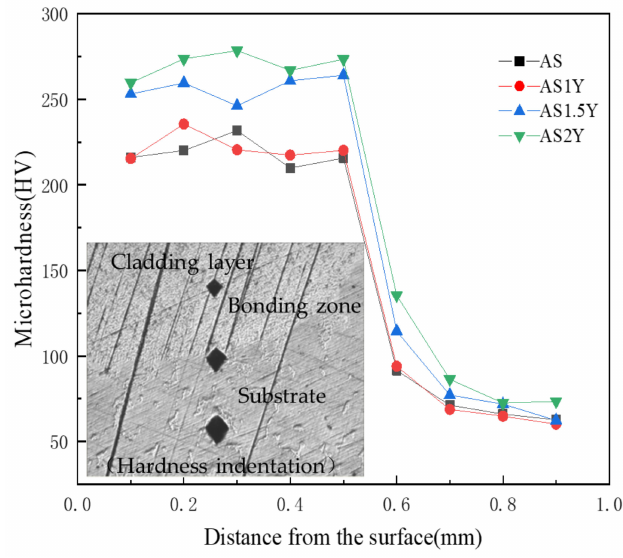
Figure 5. Microhardness distribution across the cross-section of